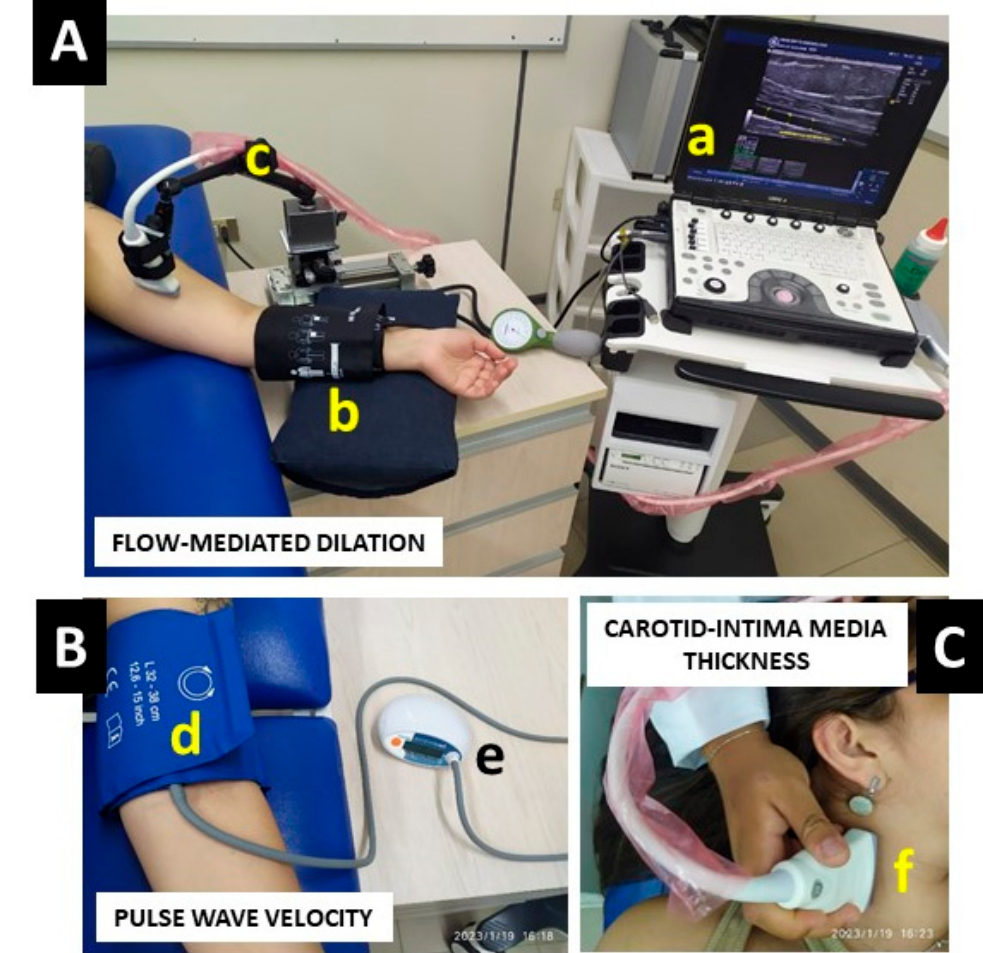
Figure 2. Flow-mediated dilation (panel A ), pulse wave velocity (panel B ), and carotid-intima media thickness (panel C ). Equipment involved in the three measurements includes; (a) a Doppler ultra- sound, (b) a blood pressure cuff to promote occlusion in the arm, (c) an adjustable mechanical three- axis precision holder, (d) a blood pressure cuff for multiple inflation/deflation, (e) Arteriograph